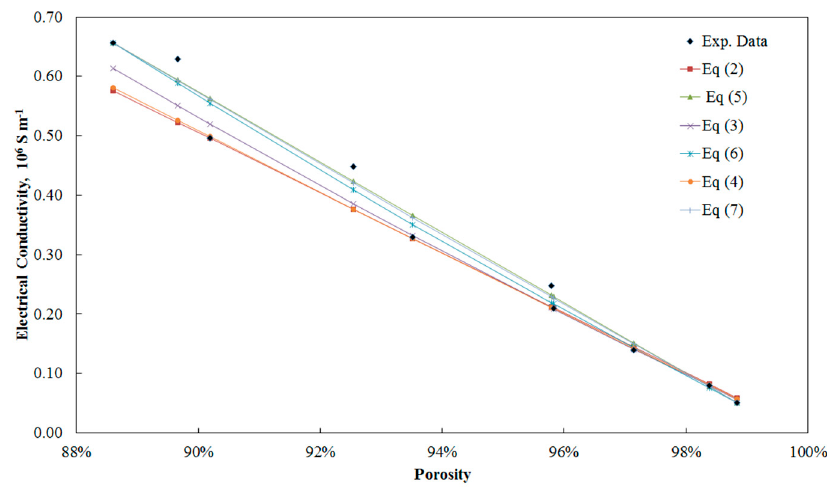
Figure 5. Fitting of different models to experimental data from Liu et al. [34].